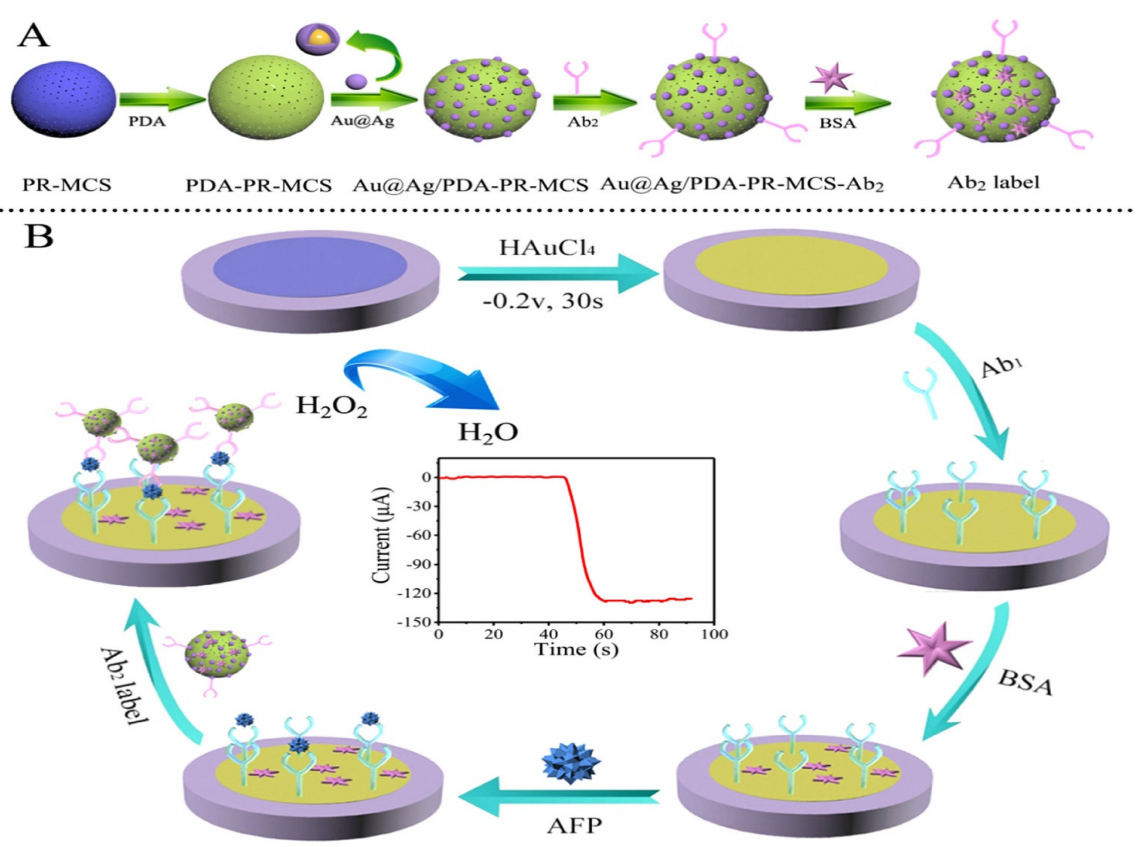
Figure 16. Schematic representation of the fabrication process for Ab2 label and sandwich–type electrochemical immunosensor for AFP detection. ( A ): Probe preparation process; ( B ): Electrode mod- ification process for the capturing of antigen and probe. PDA–PR–MCS: polydopamine–decorated phenolic resin microporous carbon spheres; PR–MCS: phenolic resin microporous carbon spheres. Reprinted with permission from [118], published by Elsevier,